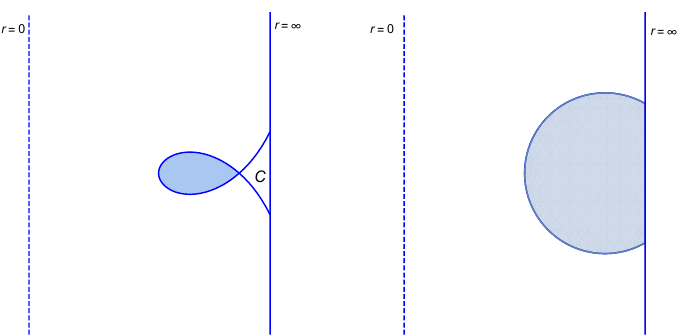
Figure 7 . Interior solutions for cases ( IIB +) ; ( IIB (cid:0) ). For these cases, (cid:11) i is negative at r min but positive at large r . The change of sign means that t Ei has a maximum so that the interior solution takes one of the forms shown. Since (cid:11) i ( r min ) > 0, in each case we must keep a piece of the solution containing r = 0. When there are no self-intersections (right) this presents no problems. And since (cid:11) i can vanish at only one value of r > r min , self-intersections are always of the form shown at left. Such self-intersections can be removed by inserting an appropriate conical singularity into the shaded (unphysical) region. In terms of the physical (unshaded) region, the e(cid:11)ect is to include two copies of the region marked C near t E = 0 and r = 1 . The (cid:12)rst copy C U of C is attached smoothly to the rest of the interior solution along the upper left boundary C , while the lower left boundary of C U is a domain wall junction with the exterior. In contrast, the second copy C L of C is attached smoothly to the rest of the interior solution along the lower left boundary C , while the upper left boundary of C U is a domain wall junction with the exterior.